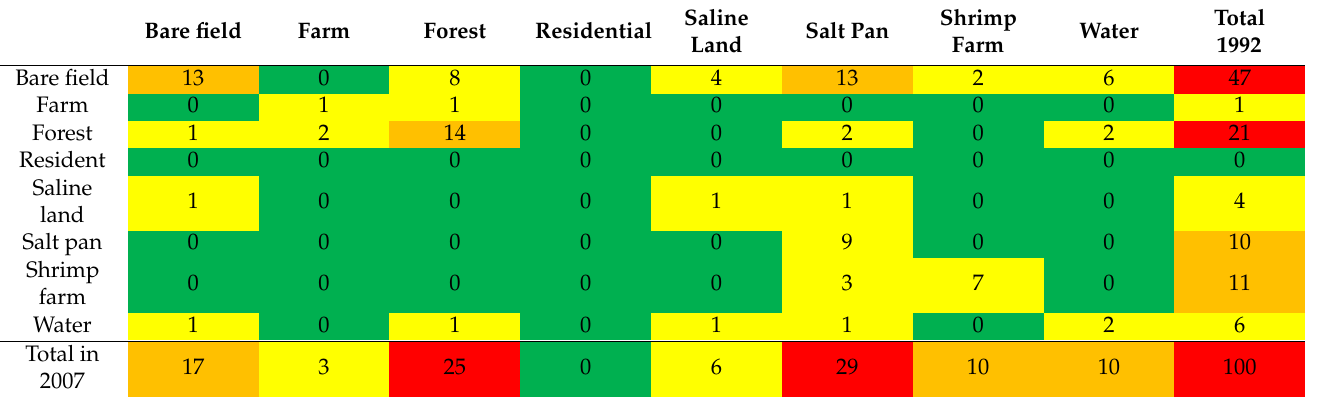
Table 4. Land use/cover change transfer matrix of the study area in P1